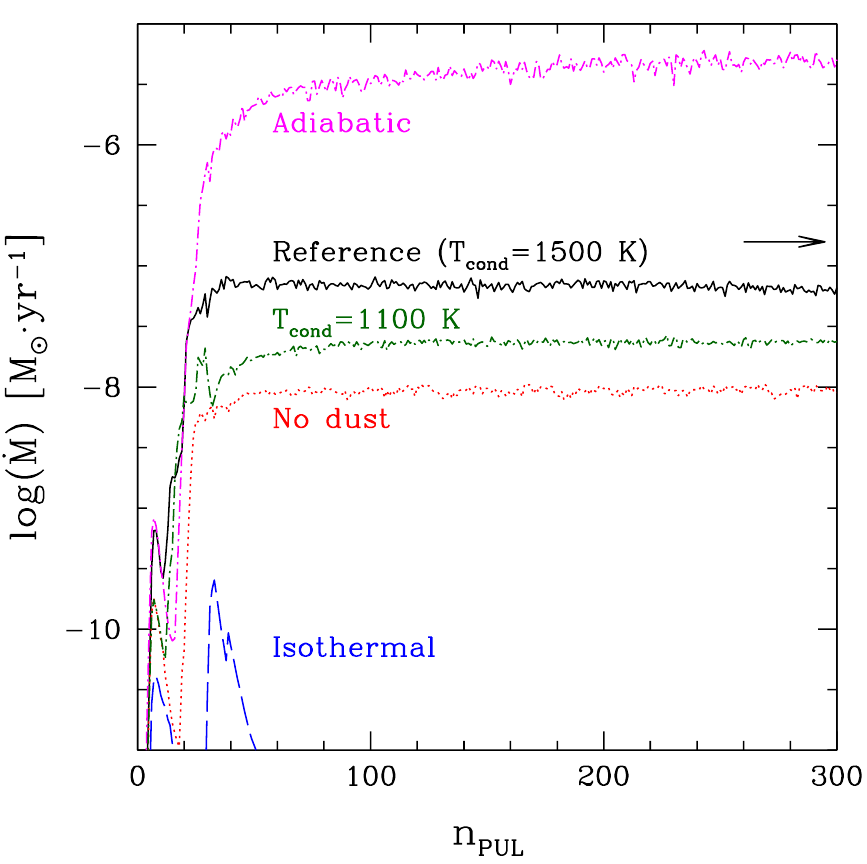
Figure 5. Theoretical mass-loss rates as a function of the pulsation number. See text for